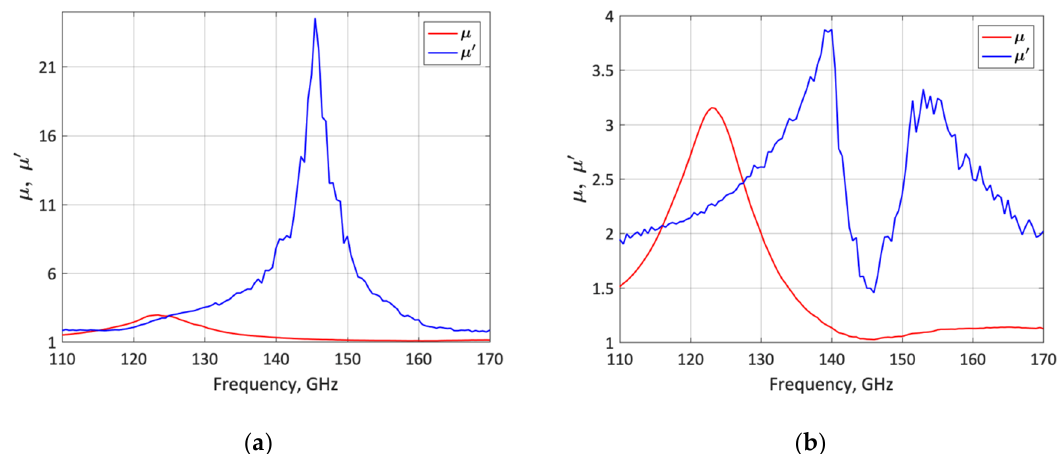
Figure 12. Stability factors ( µ and µ ’) obtained from the measured S -parameters. ( a ) Lower-frequency state (120 GHz); ( b ) upper-frequency state (140 GHz).